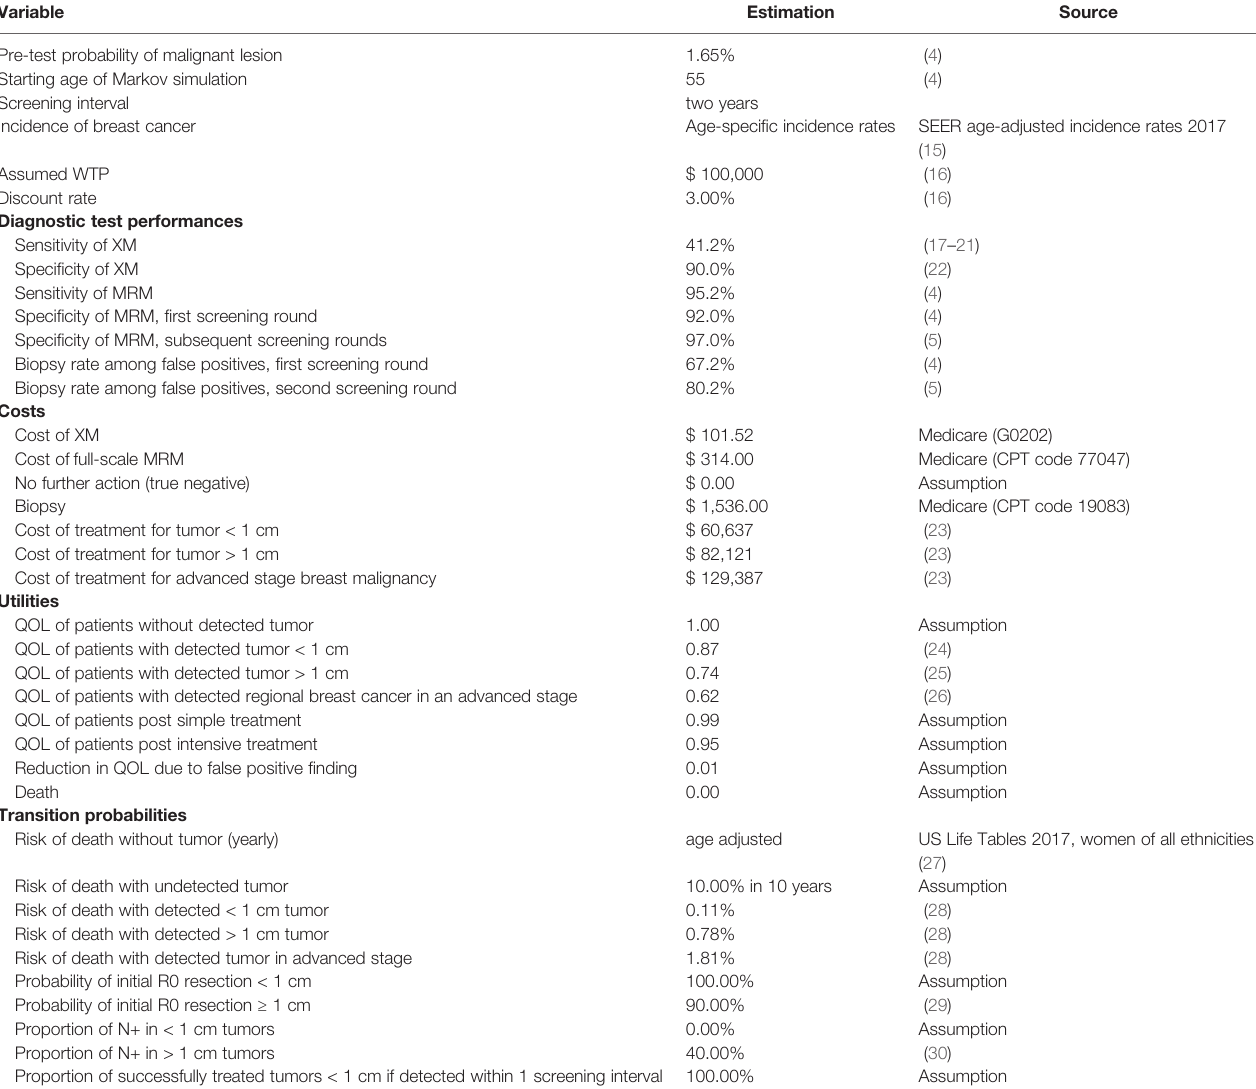
TABLE 1 | Model input parameters for the economic modelling, that have recently been published and adapted for this analysis (6, 12,